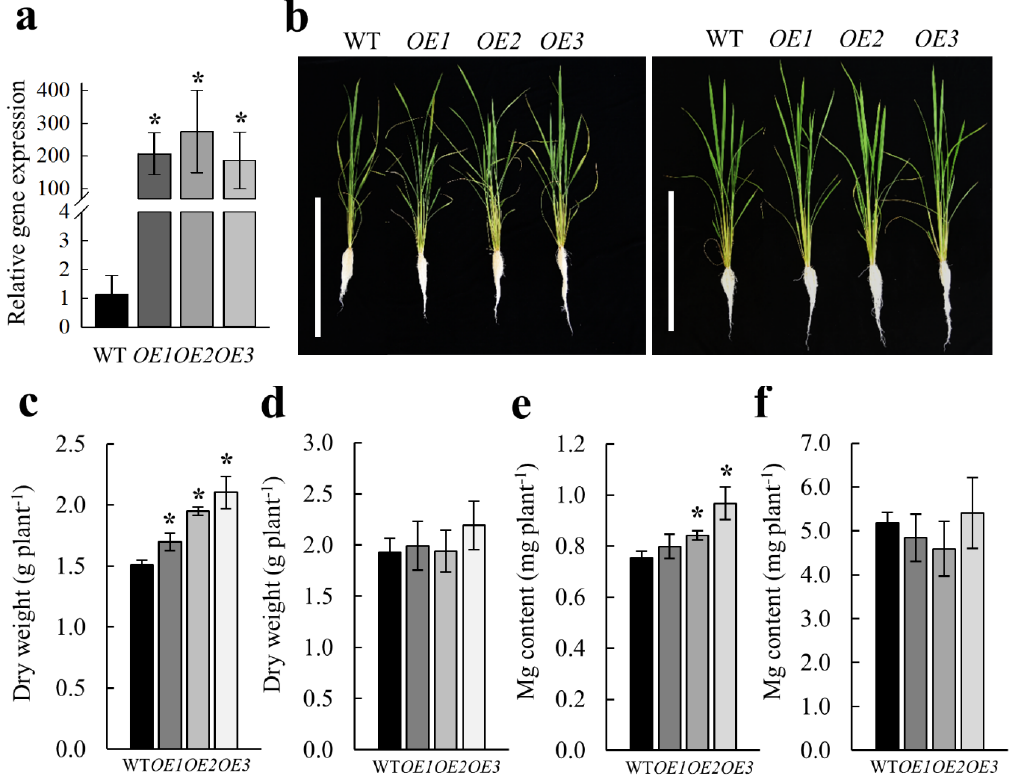
Figure 5. Overexpression of OsMGT1 improved rice growth under low ‐ Mg conditions. The WT and three overexpressing lines ( OE1 , OE2 and OE3 ) were grown with deficient (10 μ M) or sufficient (250 μ M) Mg supply. Relative expression level of OsMGT1 in three overexpressing lines ( a ). The expression level was determined by real ‐ time RT ‐ PCR. OsActin was used as an internal standard. Growth conditions ( b ). Left, 10 μ M; right, 250 μ M. Dry weight ( c , d ) and Mg content ( e , f ) under deficient and ( b ). Left, 10 µ M; right, 250 µ M. Dry weight ( c , d ) and Mg content ( e , f ) under deficient and sufficient